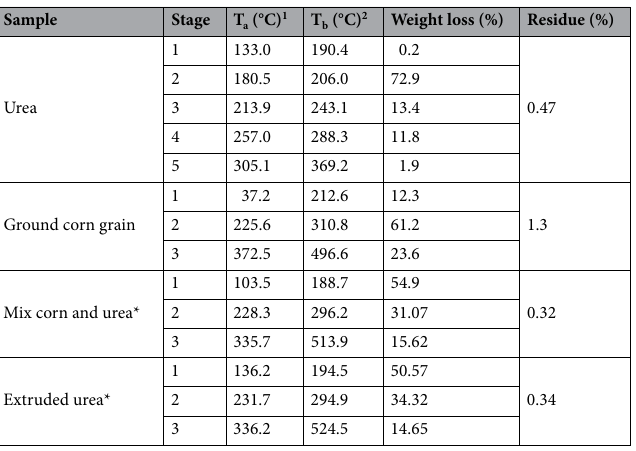
Table 2. Characterization of steps, temperature of onset of mass loss, temperature of the highest reaction rate, mass loss and residue of urea, ground corn, ground corn and urea mixture, and extruded urea in air atmosphere with heating ratio of 10 °C per min −1 . 1 Temperature obtained by Weight Loss temp method. 2 DTG peak temperature. *200% protein equivalent (700 g/kg urea, 268 g/kg ground whole corn and 32 g/kg sulfur flower).